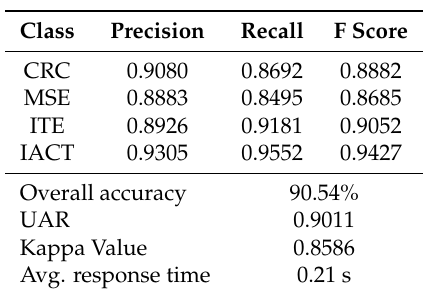
Table 3. Accuracy parameters result for four building